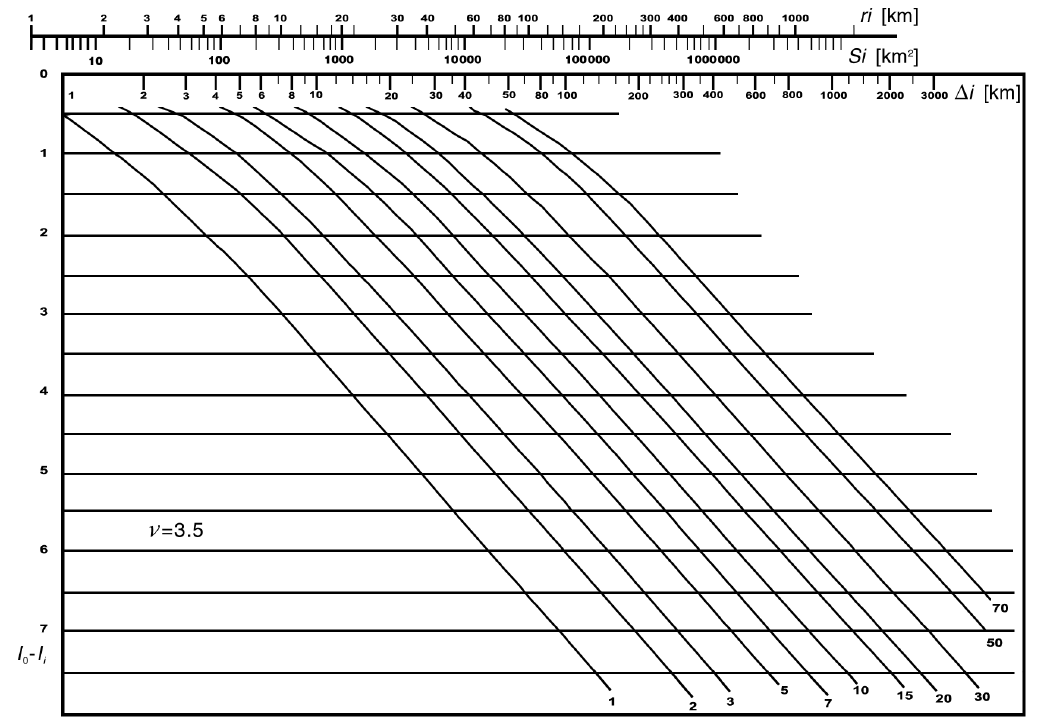
Fig. 3. Standard nomograph for determining local depht of shallow earthquakes from macroseismic data (area of isoseismal Si , their average radius ri , or distance to points of known intesity ∆ i ), for attenuation coefficient ν= 3.5 (Shebalin,